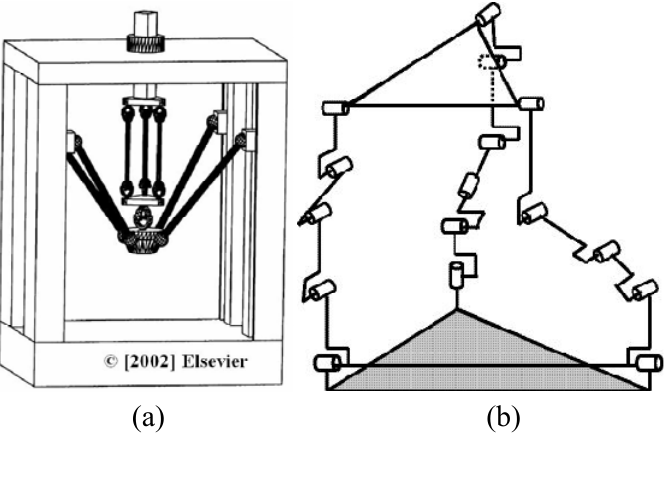
Figure 4. Five-DOF mechanisms: (a) Gao design (reprinted from [32] with permission from Elsevier). (b) Maurin design